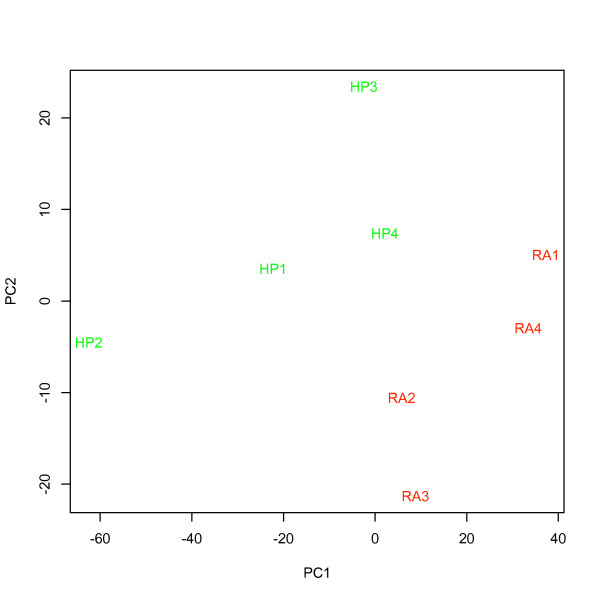
PCA for all human non-coding RNAs in hybridizations using RNA prepared from four tumor samples using both the HighPure (Roche) and RecoverAll (Ambion) RNA extraction kits for FFPE studies. "HP" (green) represents samples extracted using HighPure (Roche), and, "RA" (red) represents the same samples extracted using RecoverAll (Ambion).